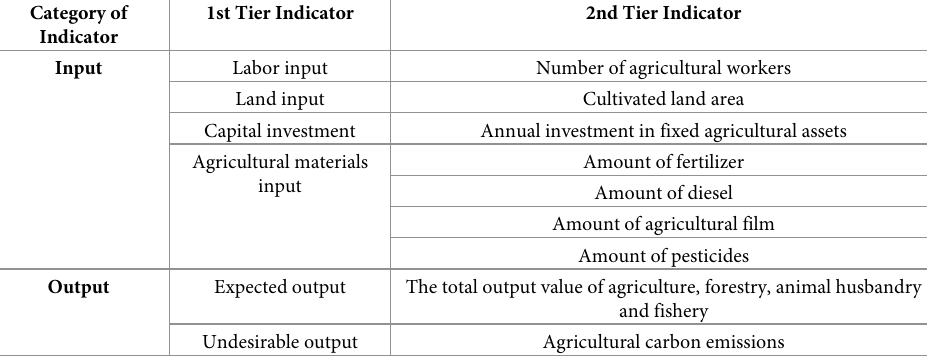
Table 2. Input and output indicators of agricultural carbon